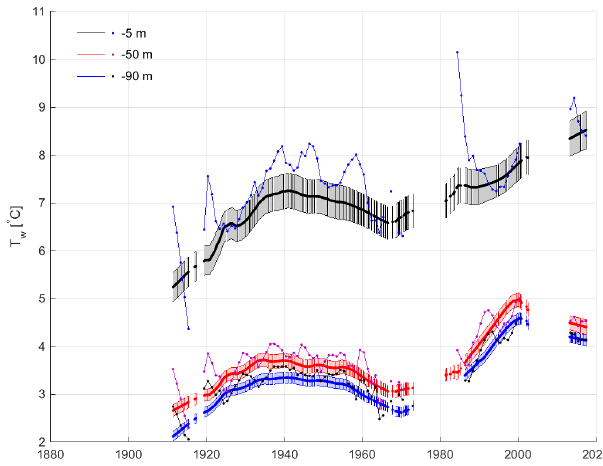
Figure 7. Average seawater temperatures in Utö at depths of − 5, − 50 and − 90m. For better visualization, we have used a combina- tion of lines in black and blue for − 5m, red and magenta for − 50m, and blue and black for − 90m, as shown in the legend.